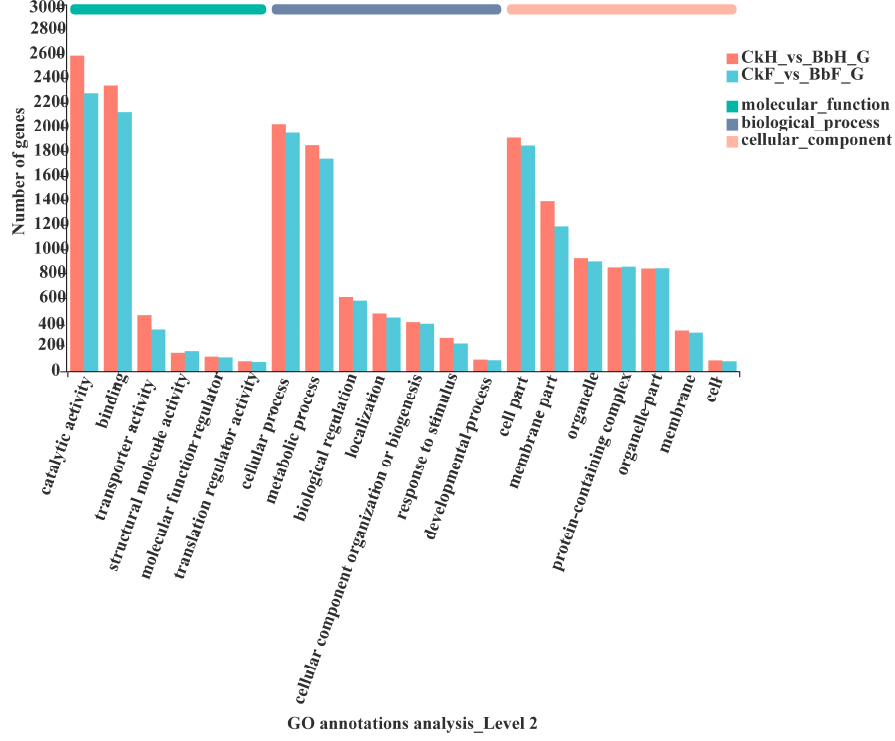
Figure 4. Gene ontology (GO) annotation of DEGs in the E. oblique transcriptome.